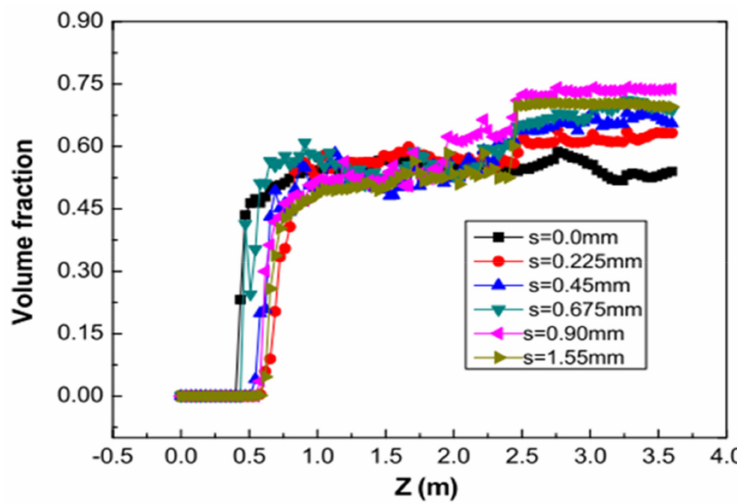
Figure 6. Volume fraction along a tube for varying fouling layer thickness [27].